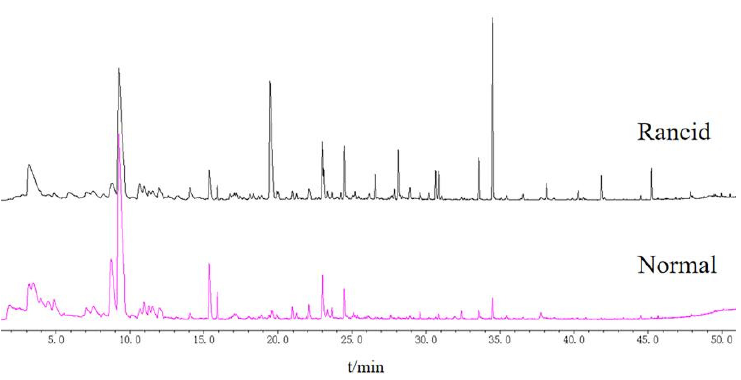
Figure 2. GC-MS total ion chromatogram of volatile components from normal and rancid ZSS sam- ples.